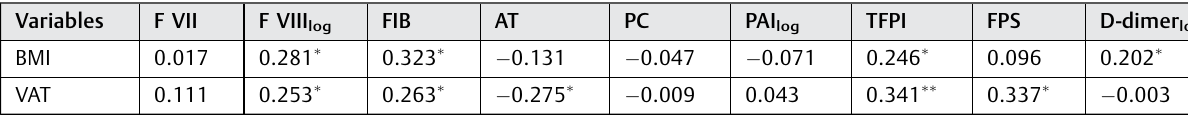
Table 3 Correlation between fat distribution markers and general hemostatic markers in the morbidly obese Variables